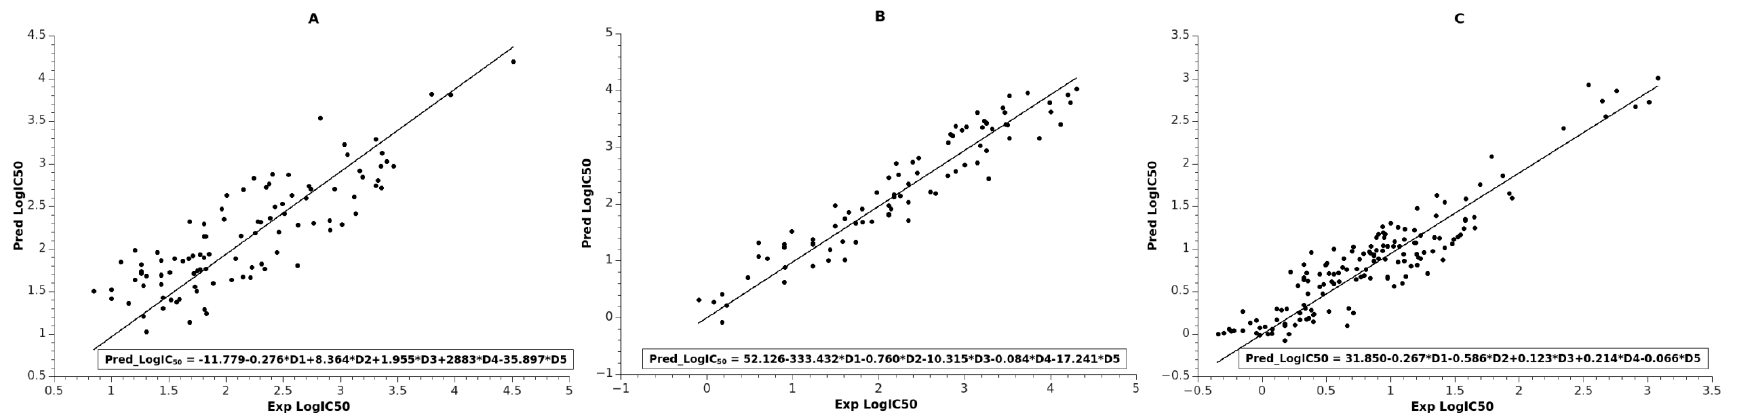
Figure 2. Linear fit between experimental and observed logIC 50 of the BMLR models: ( A ) LRRK2 set; ( B ) NMDA set; ( C ) TrkA set. Trend lines indicated by straight lines. BMLR equations in Table 2 are also incorporated in the boxes. Table 3. Binding energies (kcal/mol) and binding modes of small-molecule ligands to receptors (LRRK2, NMDA, and TrkA).